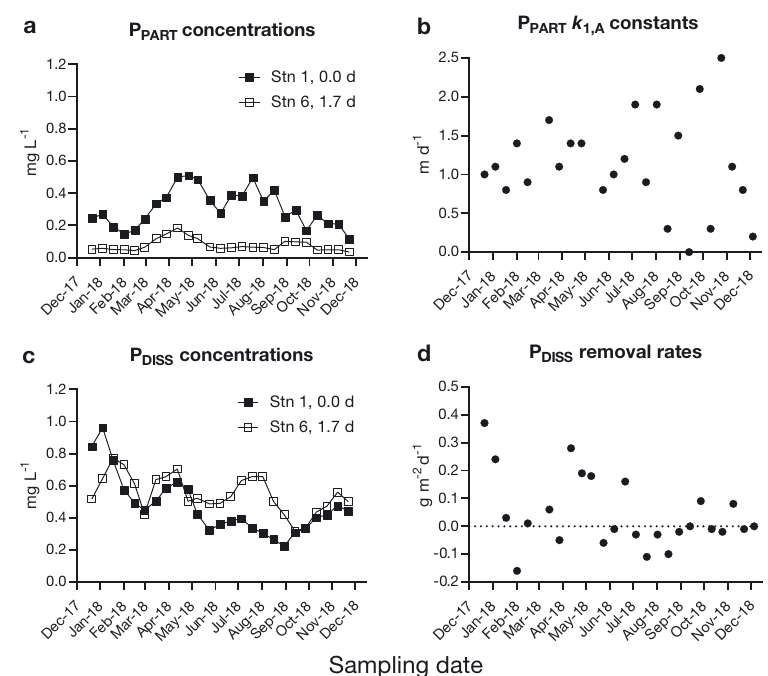
Fig. 4. Seasonal and longitudinal changes (d = hydraulic retention time in days) in particulate (P PART ) and dissolved (P DISS ) phosphorus concentrations (mg l −1 ) shown as 3-point moving averages (a,c; only Stn 1 and 6 shown for simplicity), and removal rate constants ( k 1,A , m d −1 ) of P PART and removal rates (g m −2 d −1 ) of P